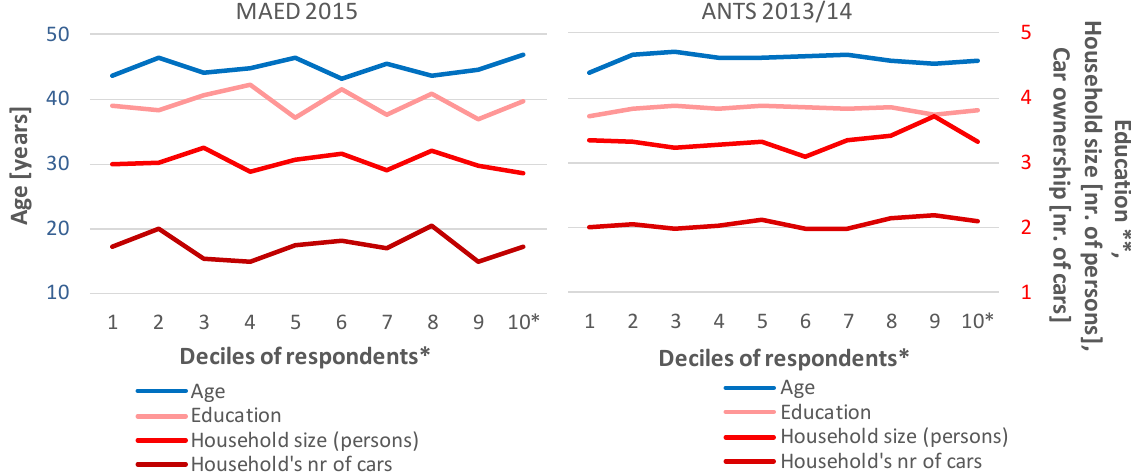
Figure 9. Socio-demographic characteristics (means) as a function of the